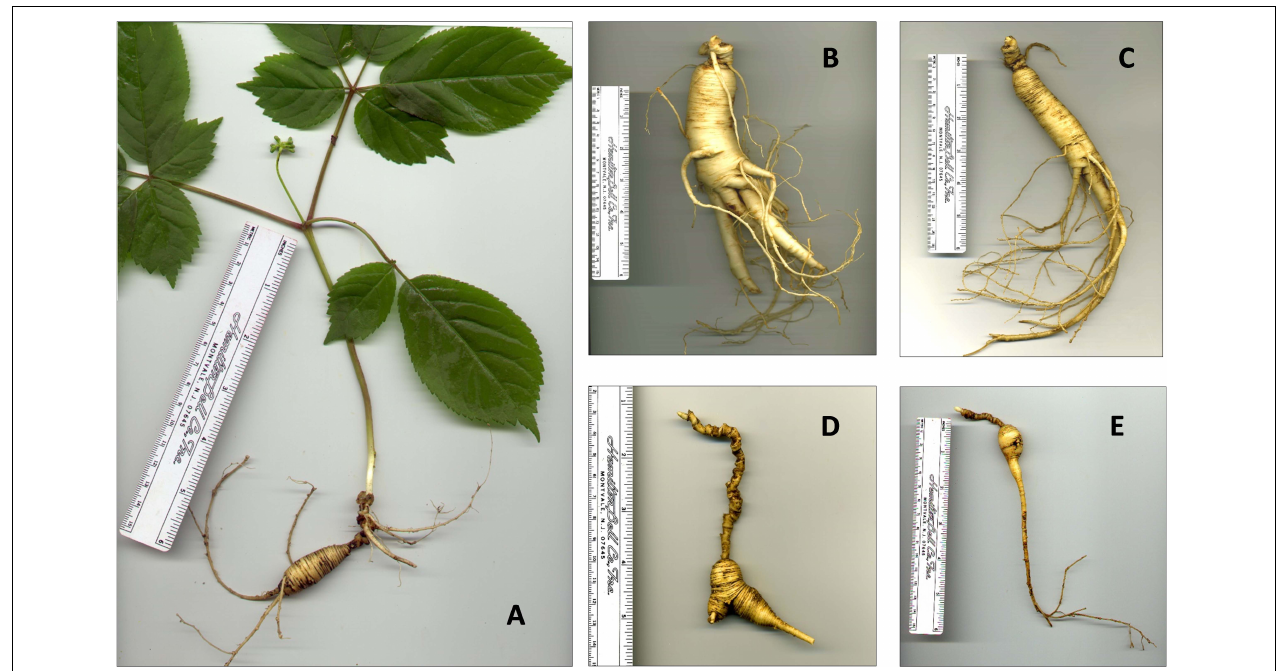
FIGURE 3 | Comparative appearances of different types of American ginseng resulting from different production practices. (A) an in situ wild-cultivated ginseng plant with top attached is provided for overall scale. Root and attached rhizomes examples include (B) cultivated under artificial-shade; (C) cultivated under a forest canopy; (D) wild; and (E) wild-simulated.